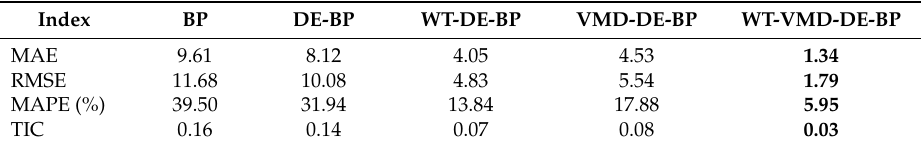
Figure 13. Error graphics of different models (Wuhan).